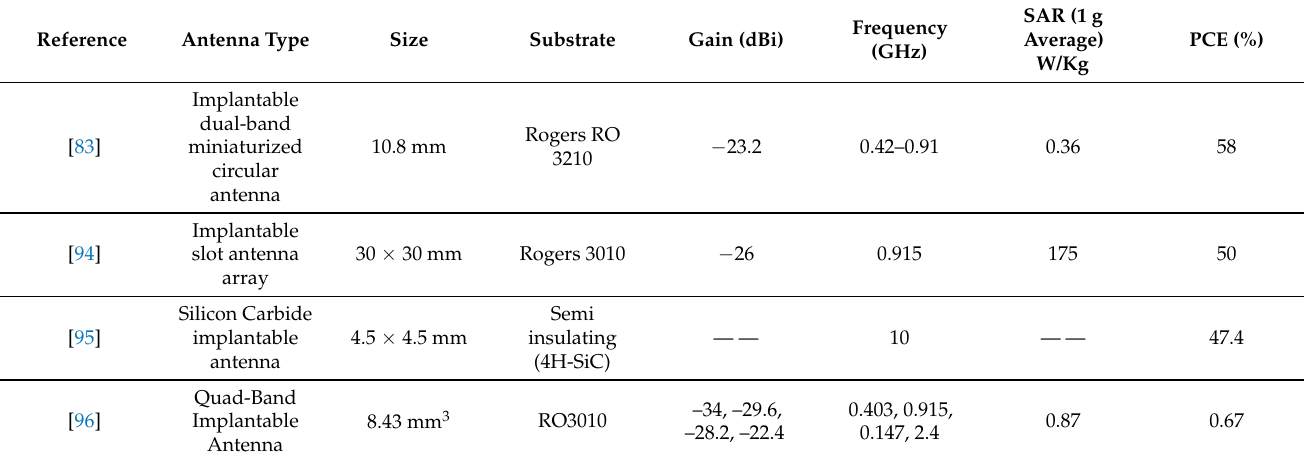
Table 3. Comparison of antenna performance for wearable and implantable medical